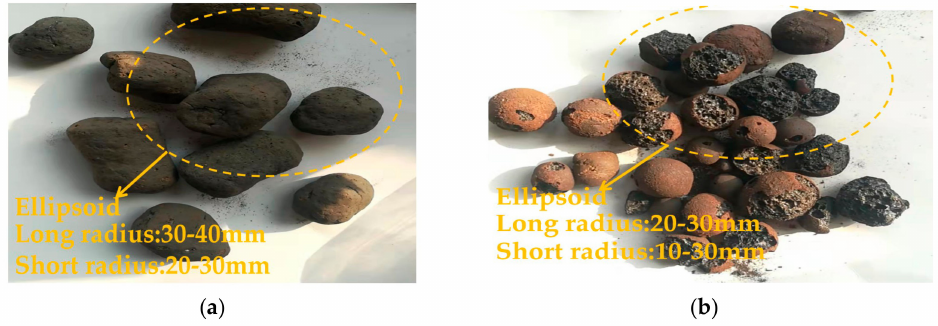
Figure 1. Photos of sludge ceramsite and clay ceramsite. ( a ) Sludge ceramsite. ( b ) Clay ceramsite.